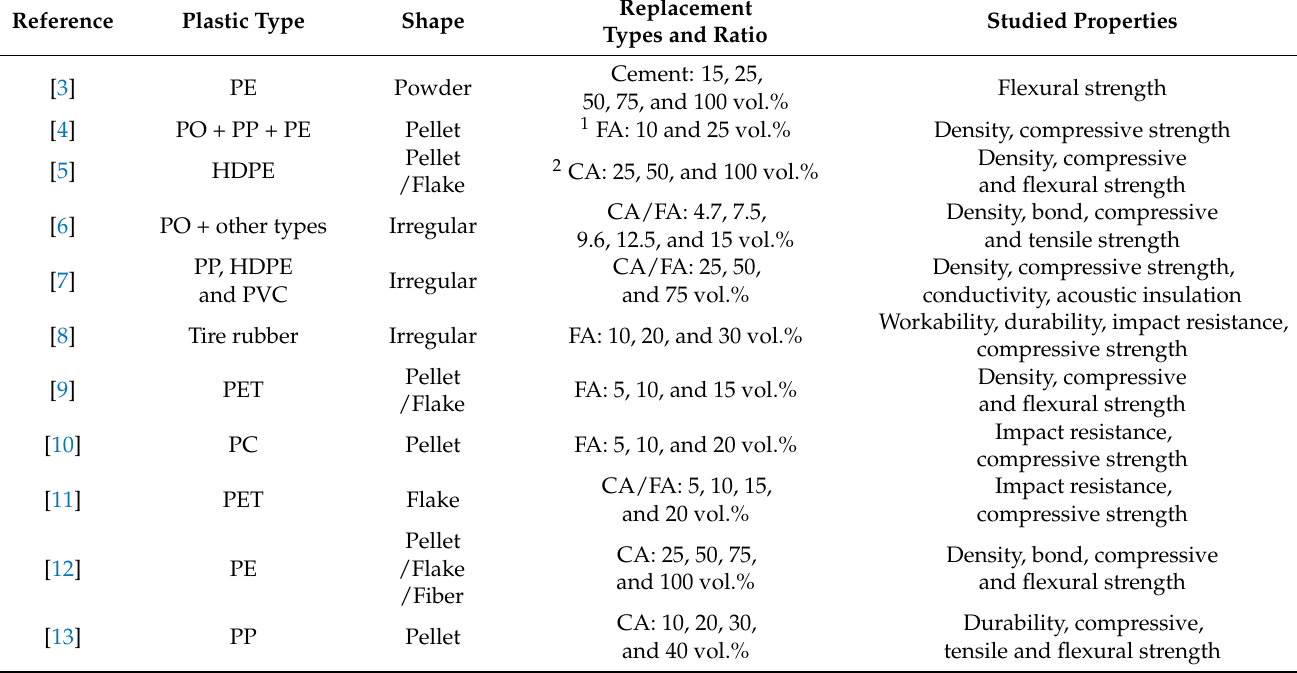
Table 1. Literature studies related to properties of cementitious composites that contain plastic